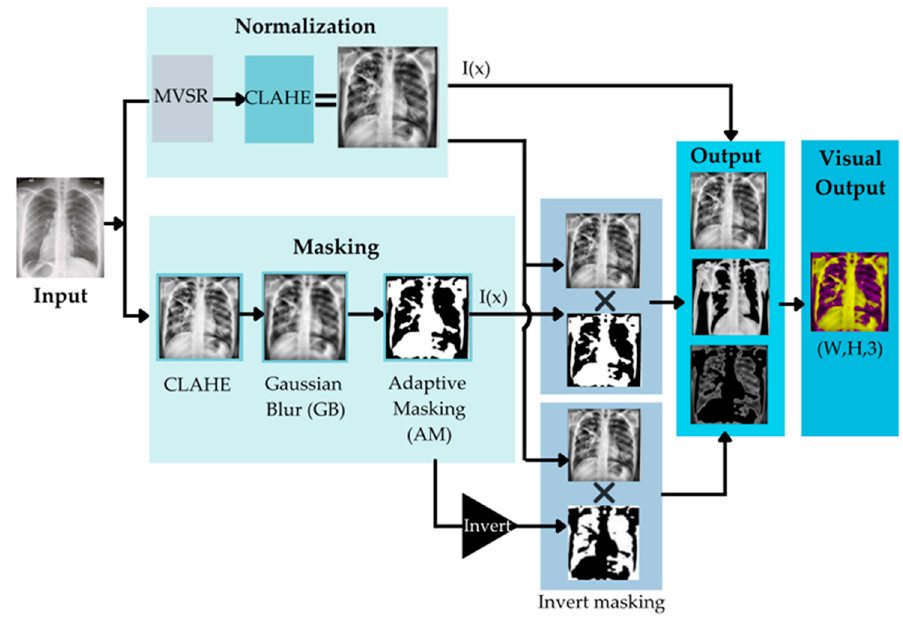
Figure 5. A flow diagram to illustrate image pre-processing steps to generate the input of a CNN model.